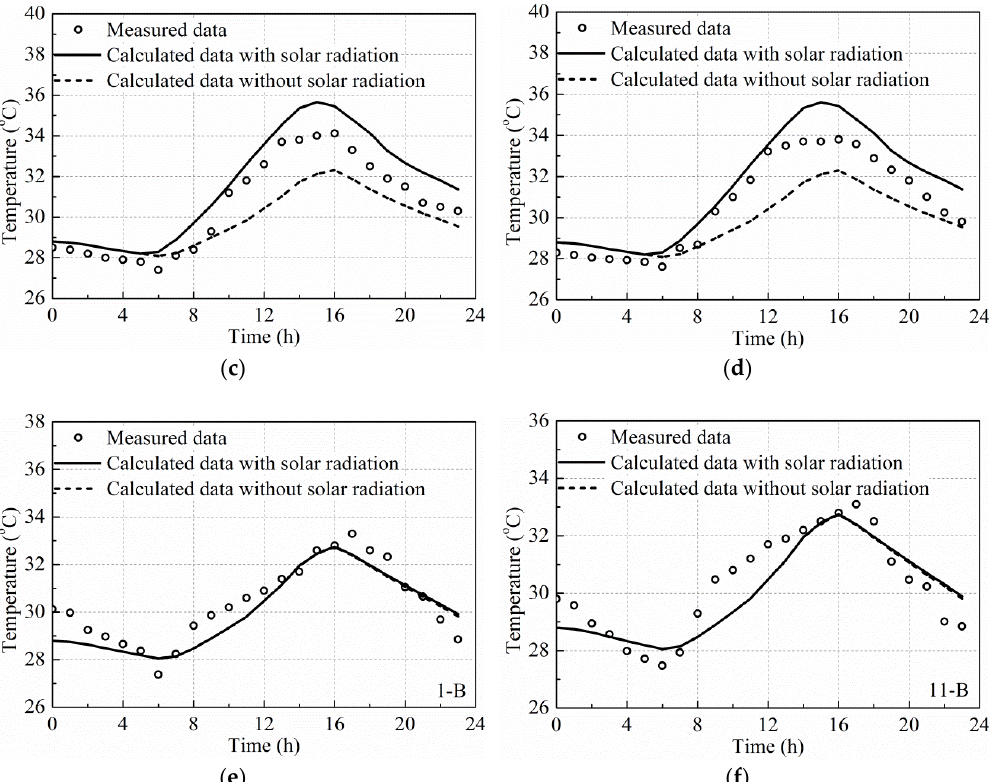
Figure 17. Influence of solar radiation on temperature distribution on cross-section of side-by-side box girder in summer (31 July 2014): ( a ) top flange (1-T); ( b ) top flange (11-T); ( c ) web (1-W); ( d ) web (11-W); ( e ) bottom flange (1-B); and ( f ) bottom flange (11-B).